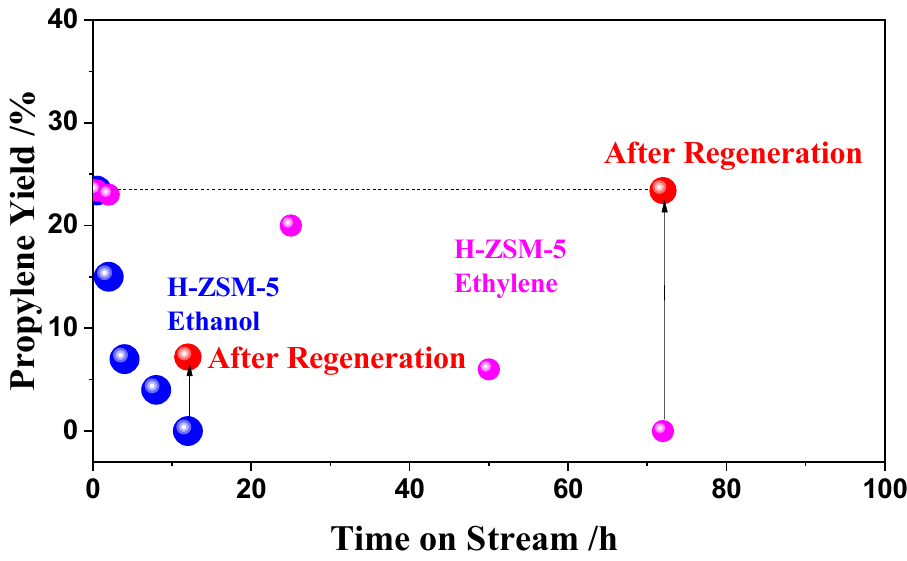
Figure 6. Stability of H-ZSM-5(80) catalysts for ethanol or ethylene conversion. Temperature: 500 ◦ C; W/F = 0.0025 g/cm 3 · min − 1 ; Feed composition: ethylene conversion (ethylene: N 2 = 1:2), ethanol conversion (ethanol: N 2 = 1:1); regeneration condition: 630 ◦ C for 0.5 h in air.